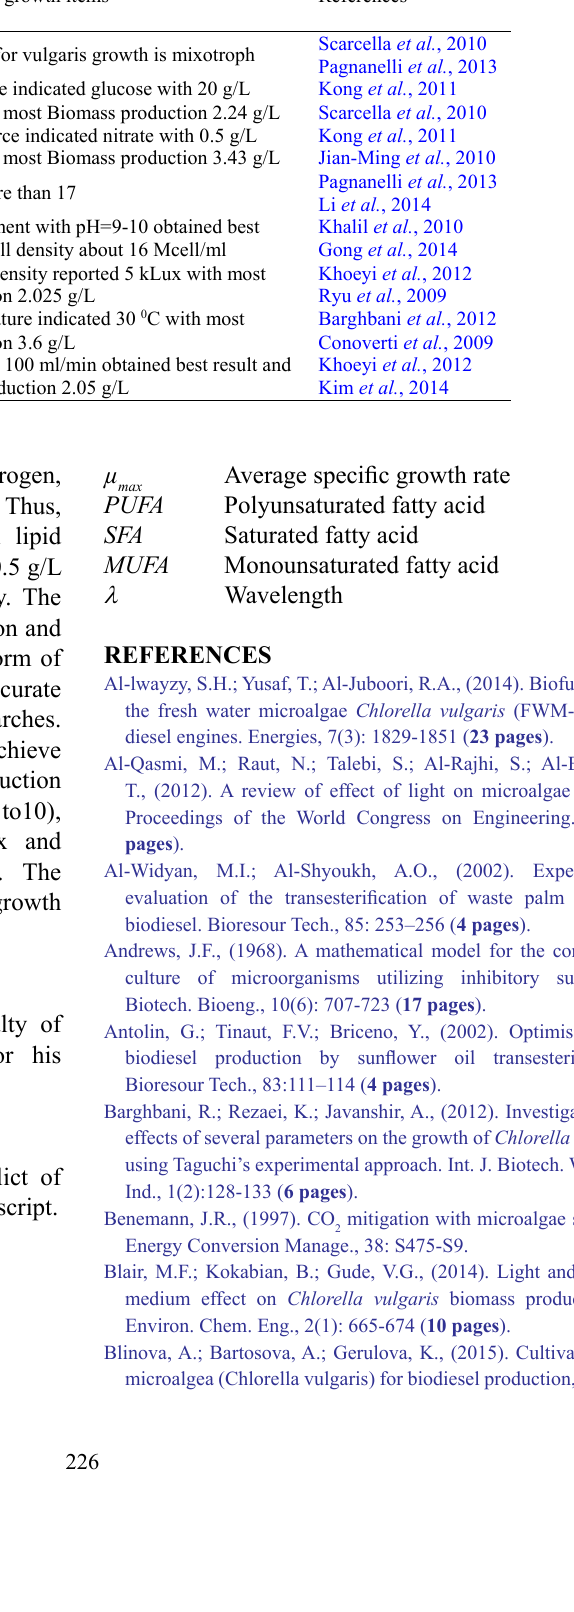
Table 2: Summary of the Chlorella vulgaris growth studies Process parameters